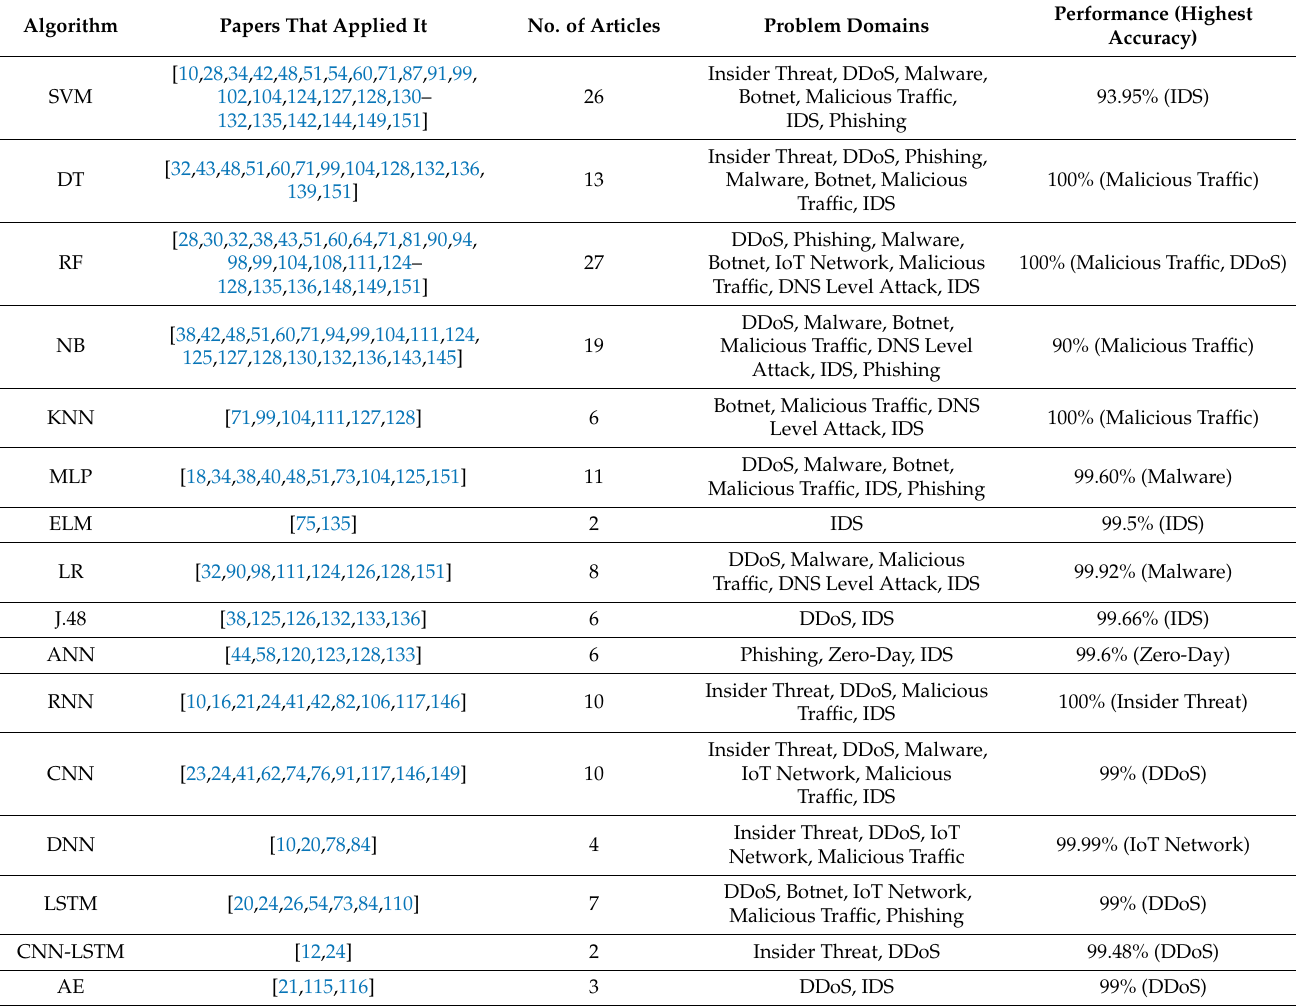
Table 3. ML and DL algorithms evaluated in the reviewed